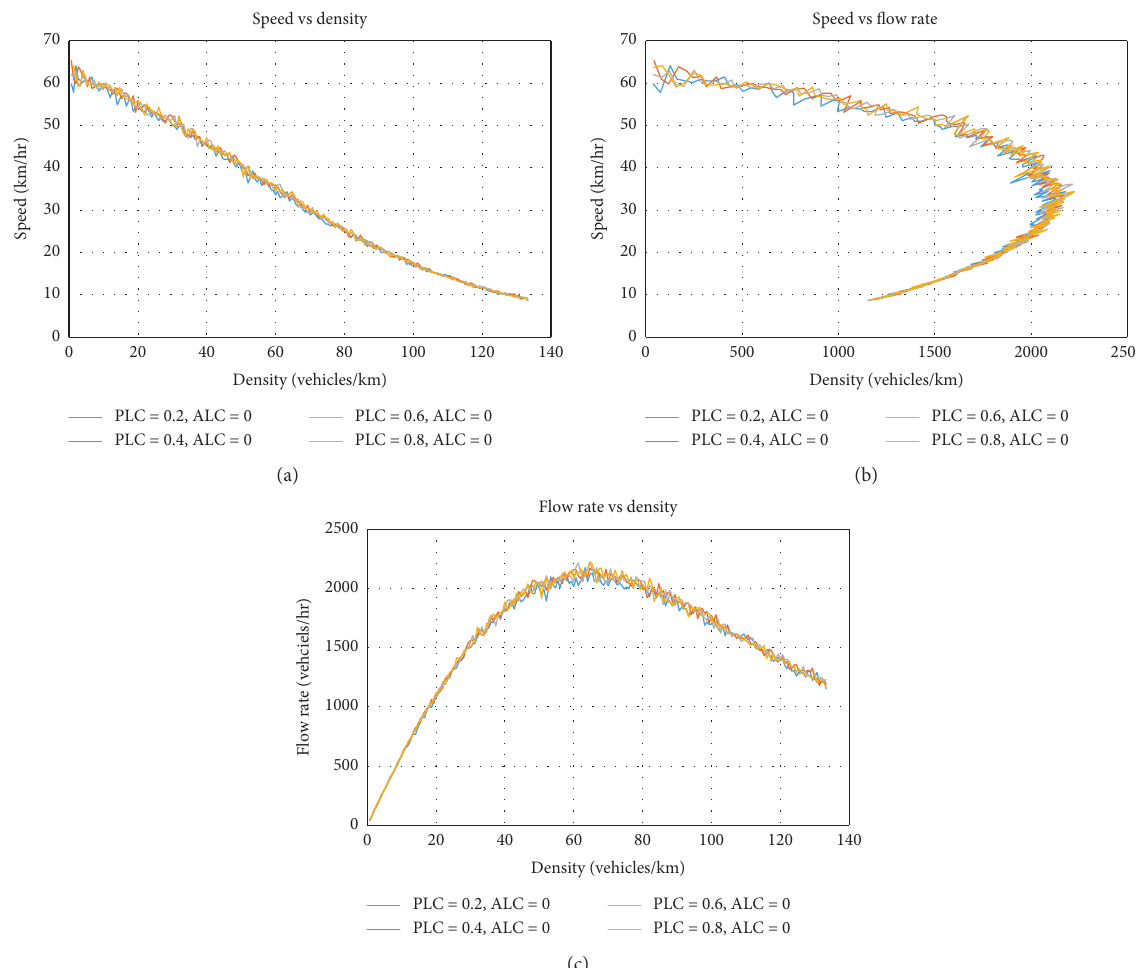
Figure 8: Traffic flow fundamental diagrams for different compositions of AC, MC, AB, and MB with different values of PLC when ALC is fixed at